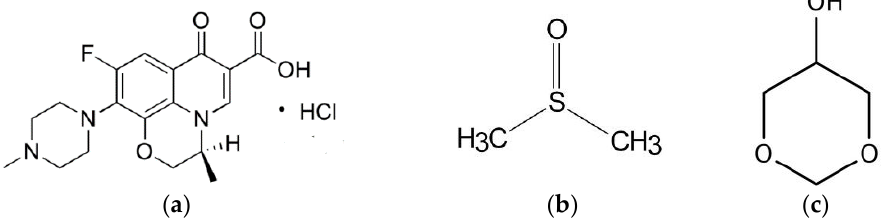
Figure 1. Chemical structure of levofloxacin HCL (Lv) ( a ), dimethyl sulfoxide (DMSO) ( b ), and glycerol formal (GF) ( c ).